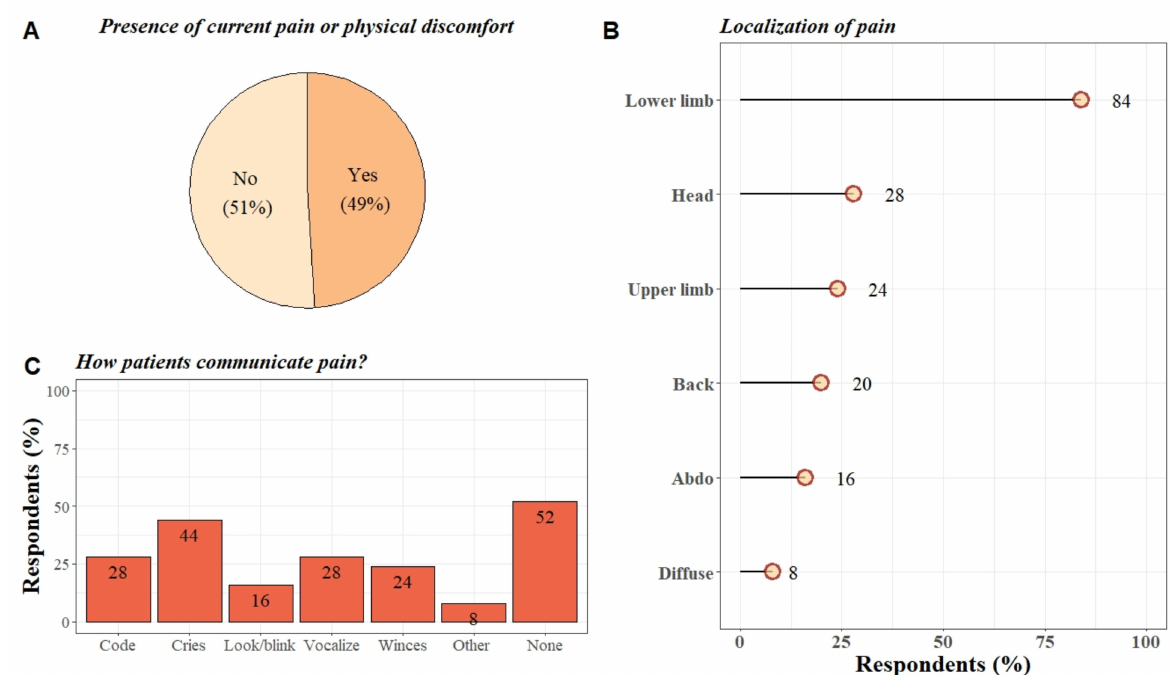
Figure 2. Summary of the results on past and current pain. ( A ) Pie chart of the distribution (in percentages) of LIS patients who had experienced pain/physical discomfort versus LIS patients who had not experienced pain/physical discomfort in the last two weeks before the study. ( B ) Lollipop graph representing the distribution (in percentages) of the different areas of the body reported as painful for these participants (multiple select answer). ( C ) Bar plot showing the distribution (in percentages) of the different means of communication used by the participants to express their pain. (Other = communication methods such as verbalization via a speech valve and the presence of acute spasticity), (Code = Use of a communication